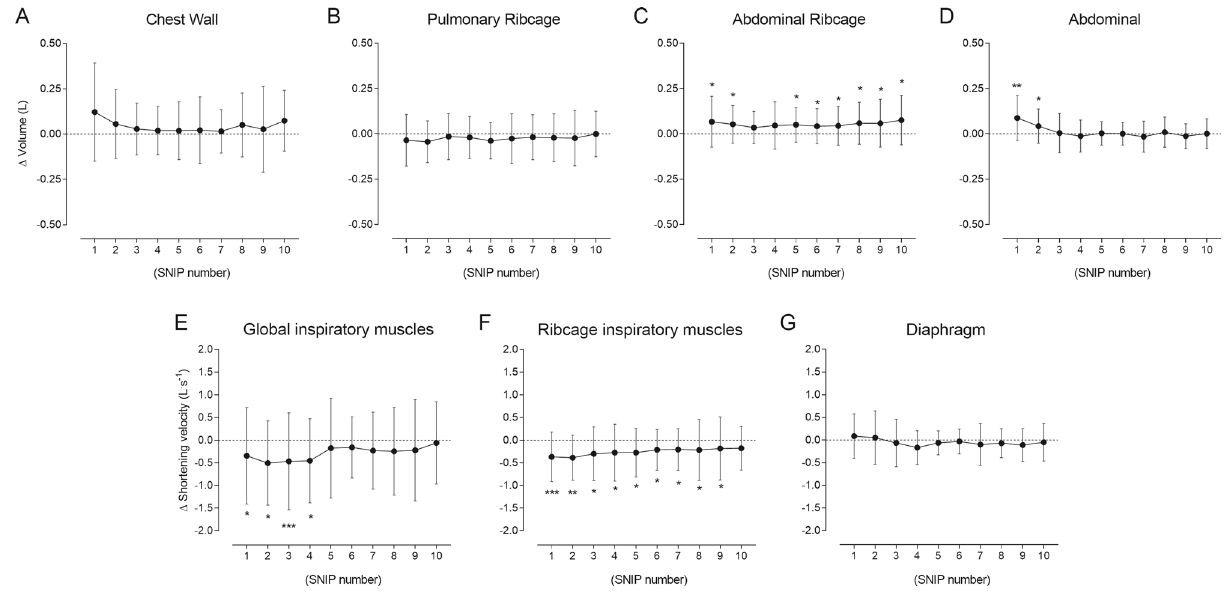
Figure 4. Data are shown as mean ± SD of all 26 subjects included in the study. Changes in chest wall (panel A ) and compartmental [pulmonary ribcage (panel B ), abdominal ribcage (panel C ), and abdominal (panel D )] volumes, shortening velocity index of the global inspiratory (ΔV CW /Ti– panel E ), ribcage (ΔV RCp /Ti – panel F ), and diaphragm (ΔV AB /Ti – panel G ) muscles obtained during the SNIP maneuvers during recovery were compared with pre-fatigue values (line at zero). * p < 0.05; ** p < 0.01; and *** p < 0.0001.